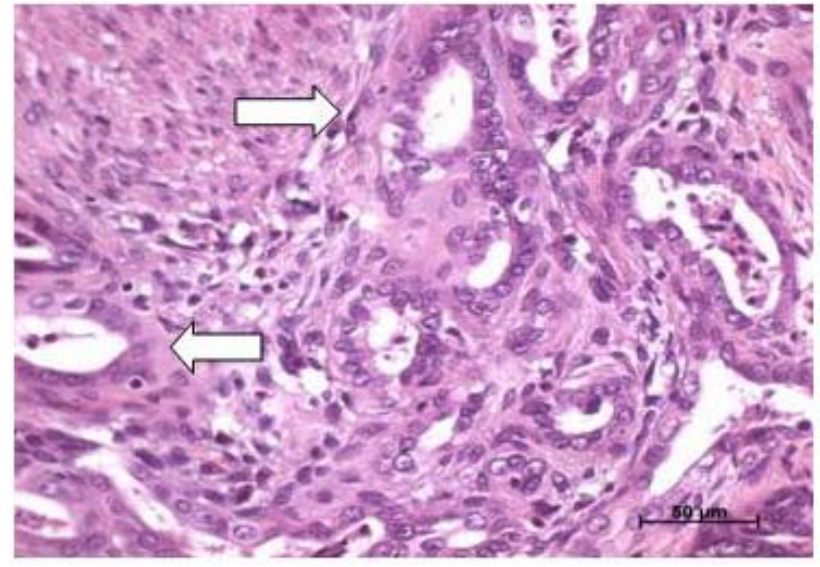
FIGURE 1. Recanalization of the vas deferens demonstrated by small ducts surrounded only by epithelial cells without a muscle